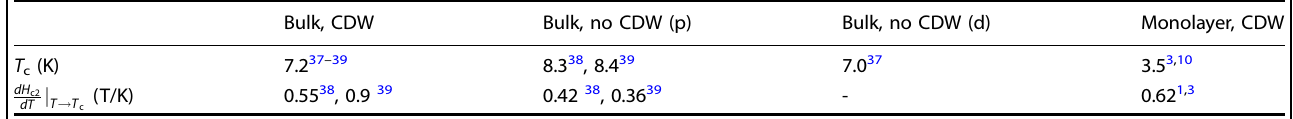
Table 1. A summary of the experimental results of key parameters pertaining to superconductivity in bulk and monolayer NbSe 2 with CDW, and with CDW removed by pressure (p) or disorder (d). Bulk, CDW